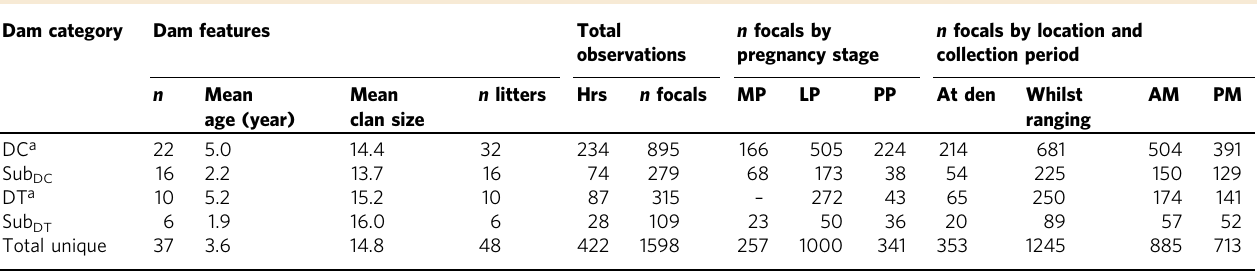
Table 2 Metadata on the focal behavioural observations of meerkat